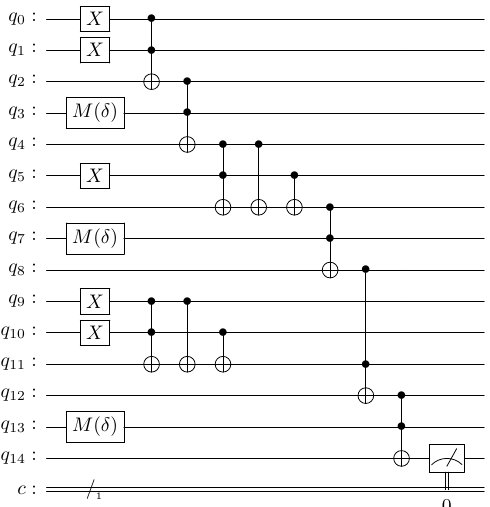
Figure 13. The quantum inferential circuit modified for the uncertainty experiment. The Hadamard gates of quantum lines q 3 , q 7 , and q 13 were replaced by M ( δ ) gates, so as to configure inaccurate rules. The Hadamard gates of quantum lines q 0 , q 1 , q 5 , q 9 , and q 10 were substituted by X gates, in order to set the veracity of the facts totally true (no imprecision).